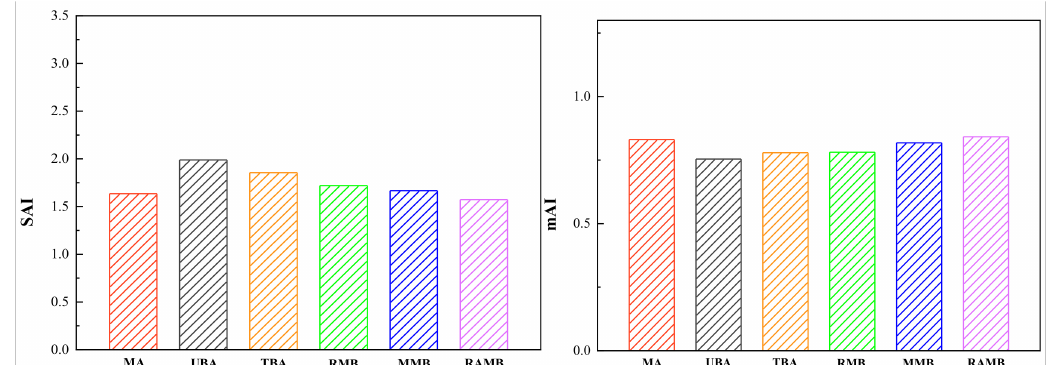
Figure 15. SAI and mAI of six asphalts after long-term